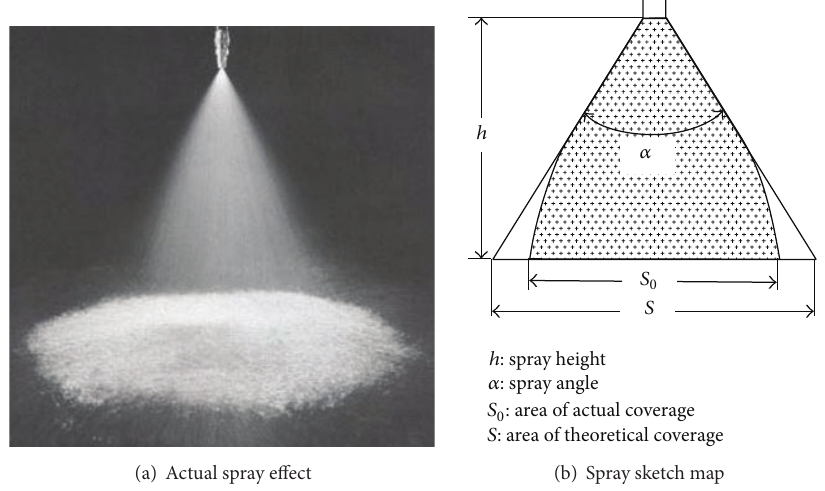
Figure 6: Spray with full cone